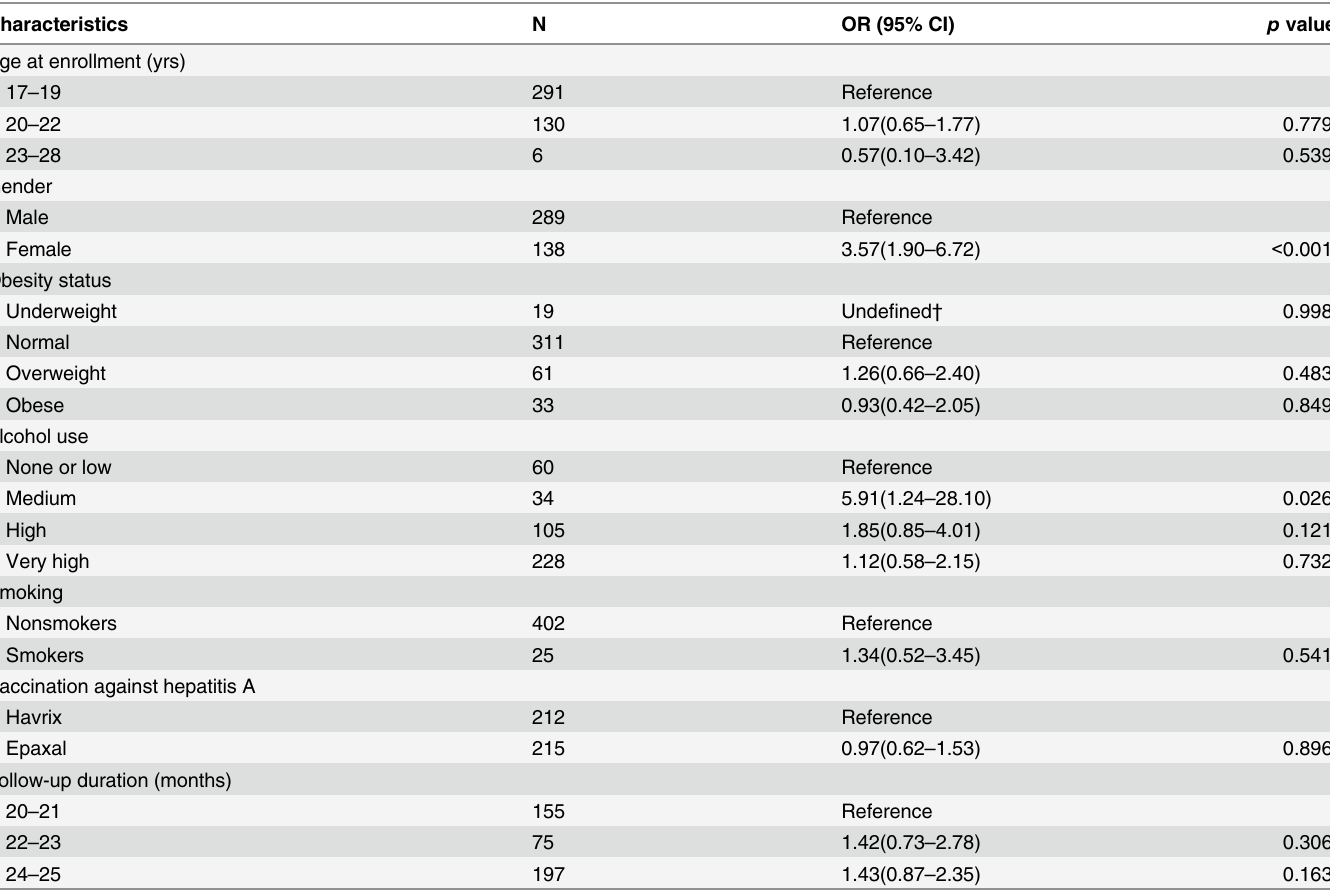
Table 2. Related factors for seropositivity using a multiple logistic regression model *